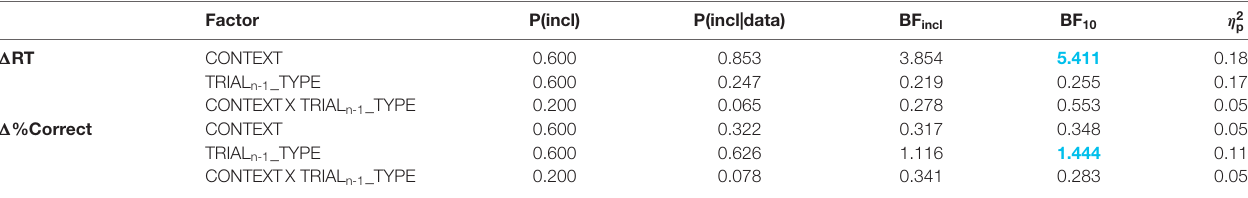
TABLE 2 | Inferential analyses of behavioral changes in trial n .